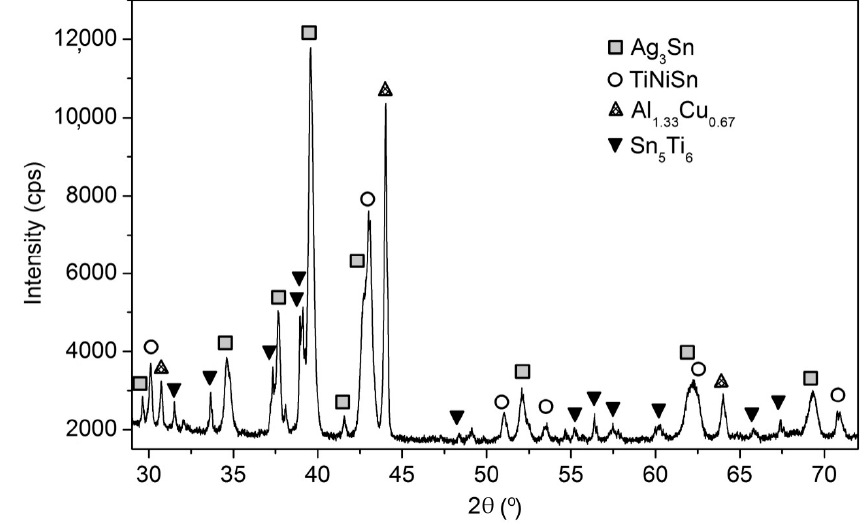
Figure 3. A part of the X-ray diffractogram of the equimolar AlAgCuNiSnTi alloy, as-cast.